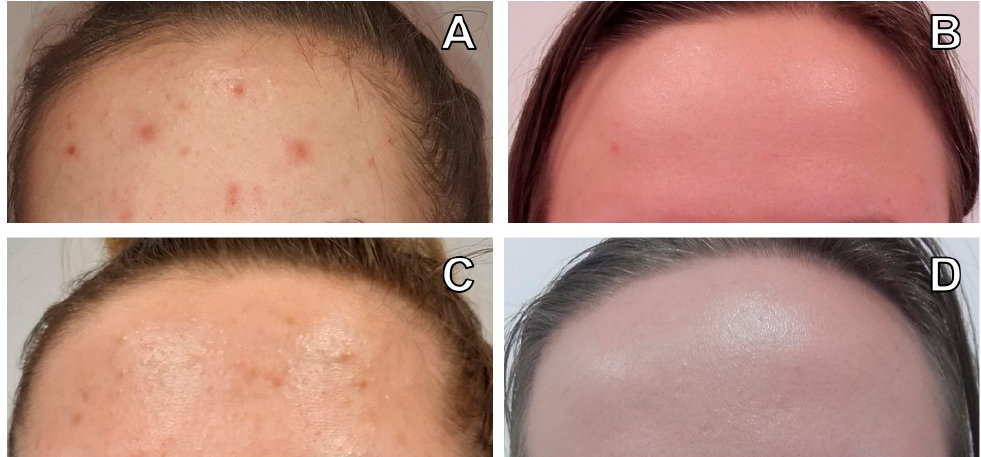
Figure 3. Example of participant’s forehead: ( A ) from AV group before hydrogen purification (HP); ( B ) from CS group before HP; ( C ) from AV group 14 days after HP; ( D ) from CS group after HP.